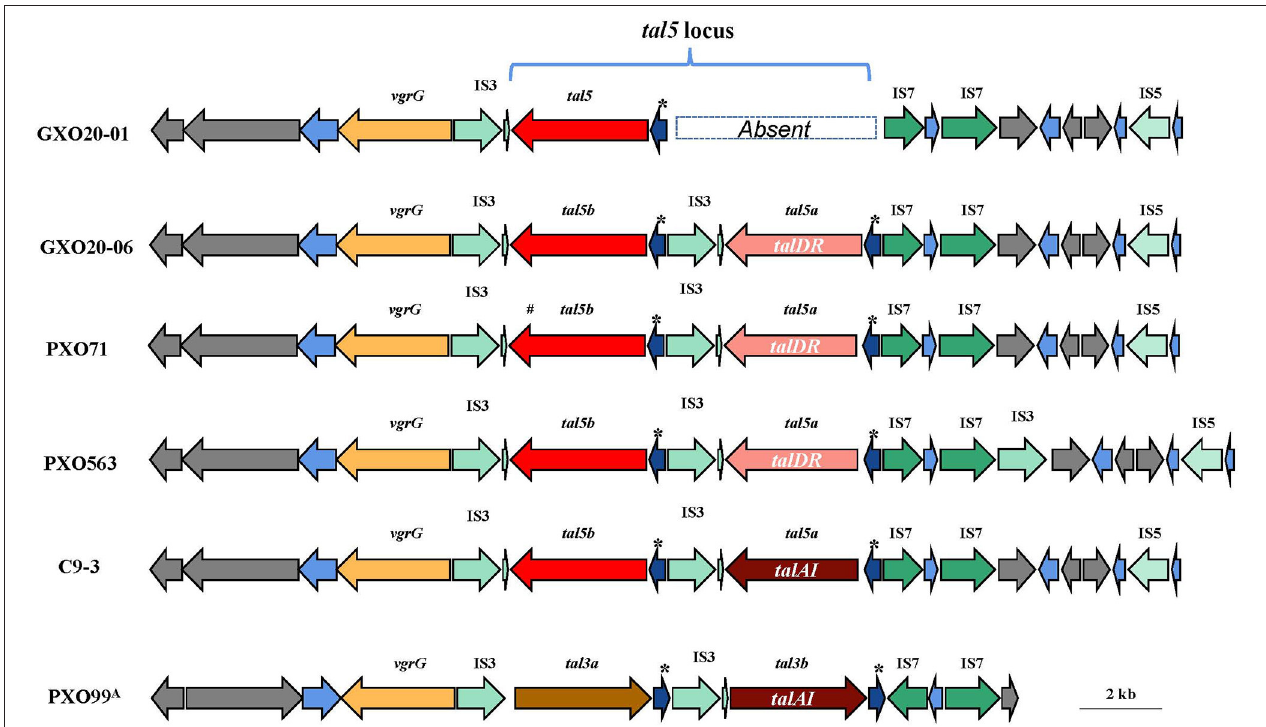
FIGURE 4 | Comparison of the genomic location that contains the tal5 gene cluster. Genes are depicted by arrows indicating the transcription direction. The “*” indicates the direct repeat sequences. tal5a of C9-3 is a truncated tal gene encoding a TalAI